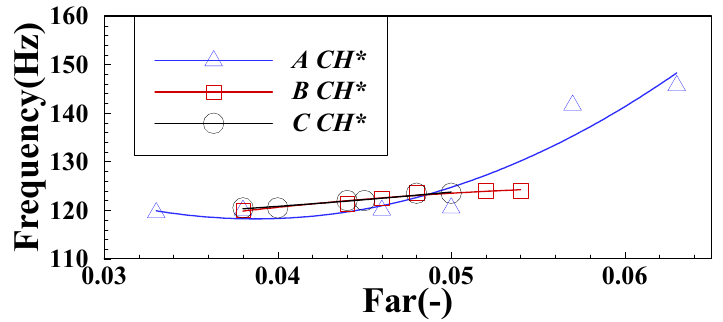
Figure 24. Variation of CH* pulsation frequency.